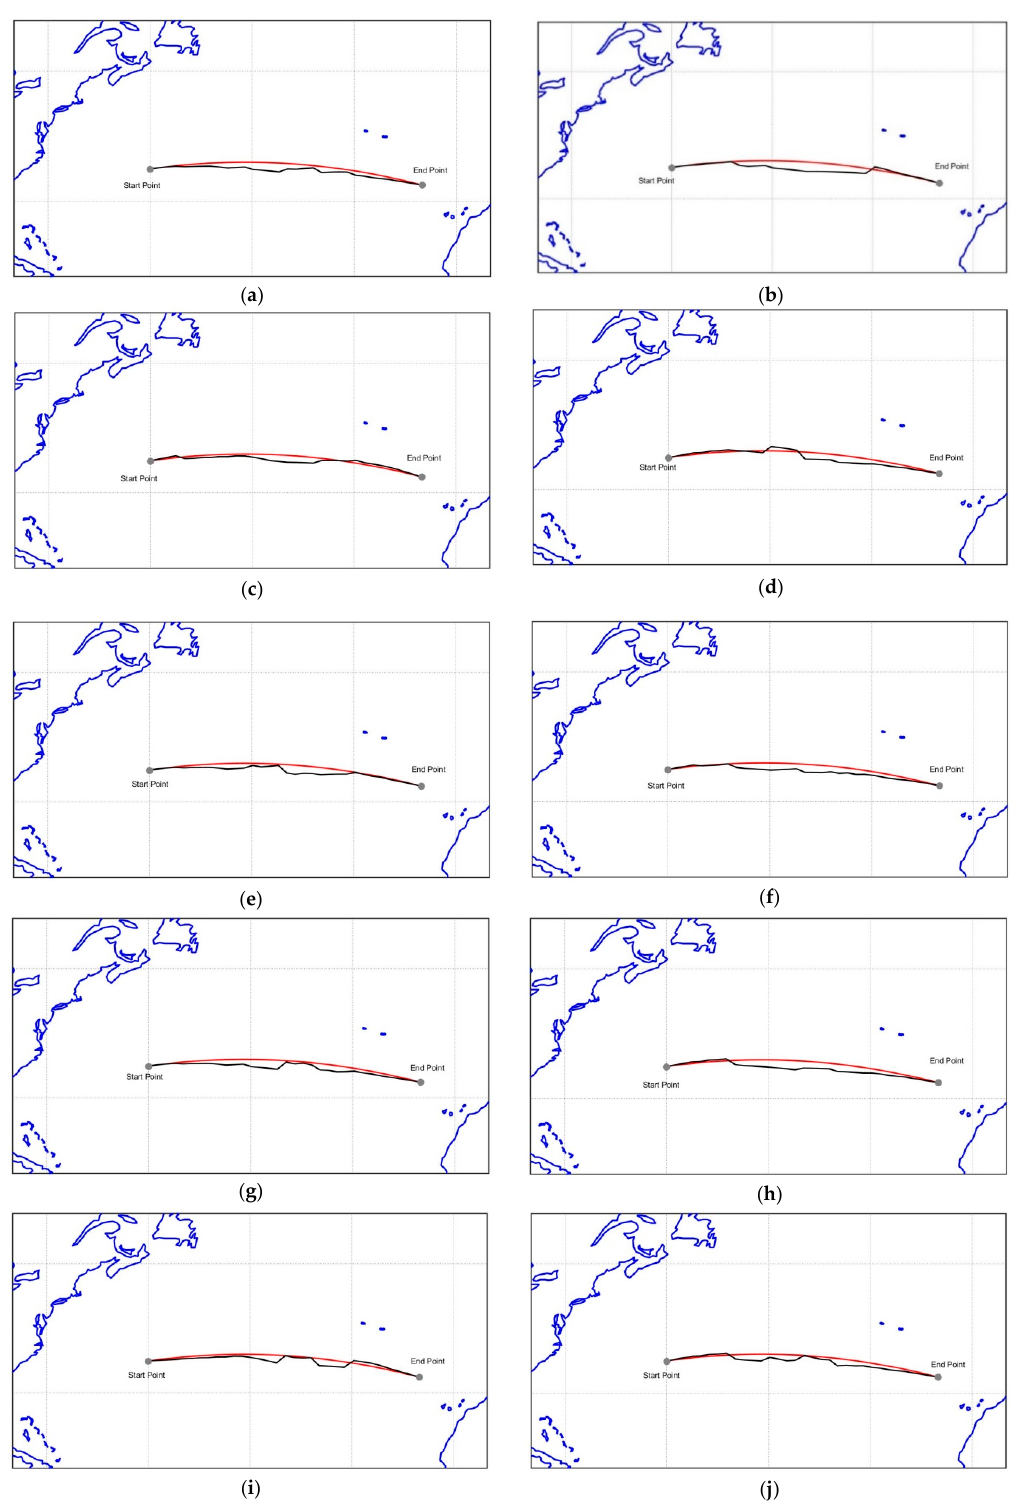
Figure 9. Sensitivity analysis at F N = 0.15 based on JONSWAP (left) and Torsethaugen (right) wave